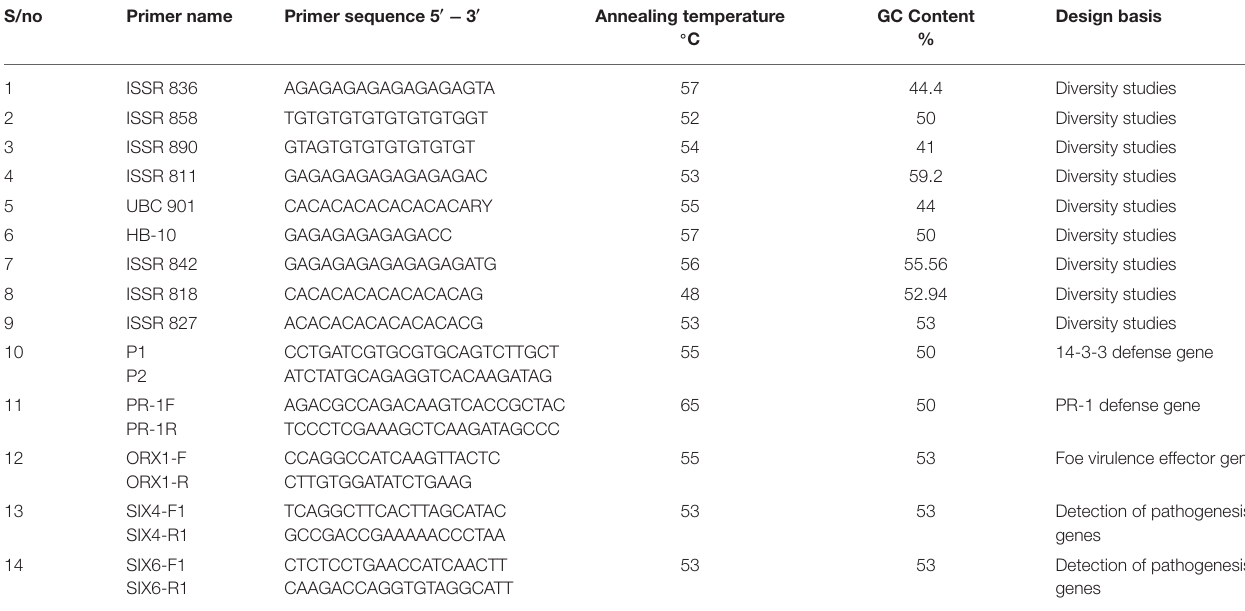
TABLE 4 | ISSR primers used for genetic diversity study, defense-related gene, and putative virulence effector genes.